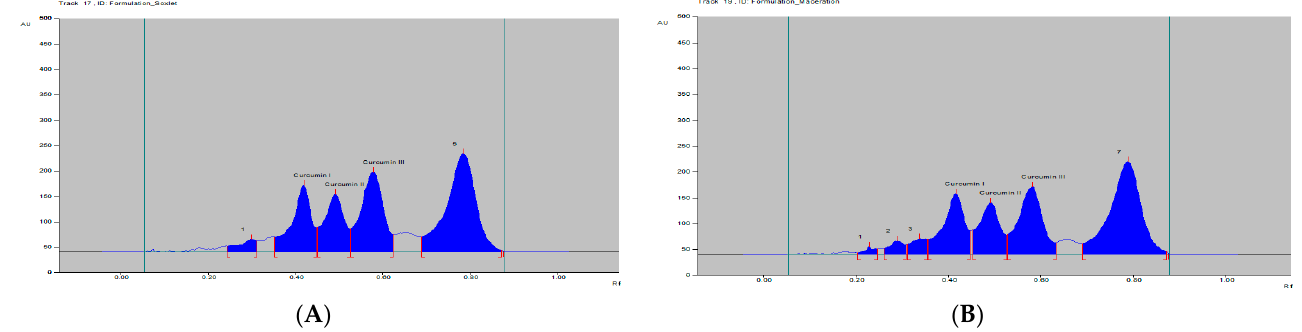
Figure 5. HPTLC densitogram of C. longa formulation extract by ( A ) soxhlet and ( B ) maceration. Table 5. Contents (% w/w ) of curcumins I–III in different samples of C. longa . Samples Cur. I Cur. II Cur.